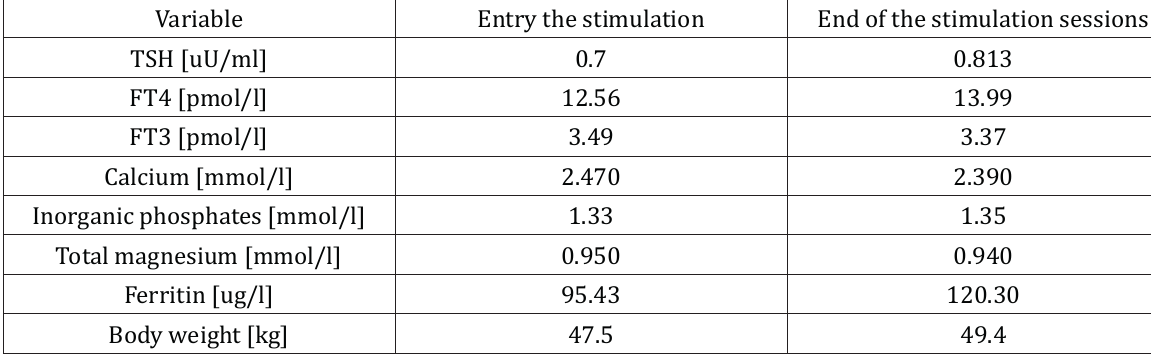
Table 4. Changes in blood parameters